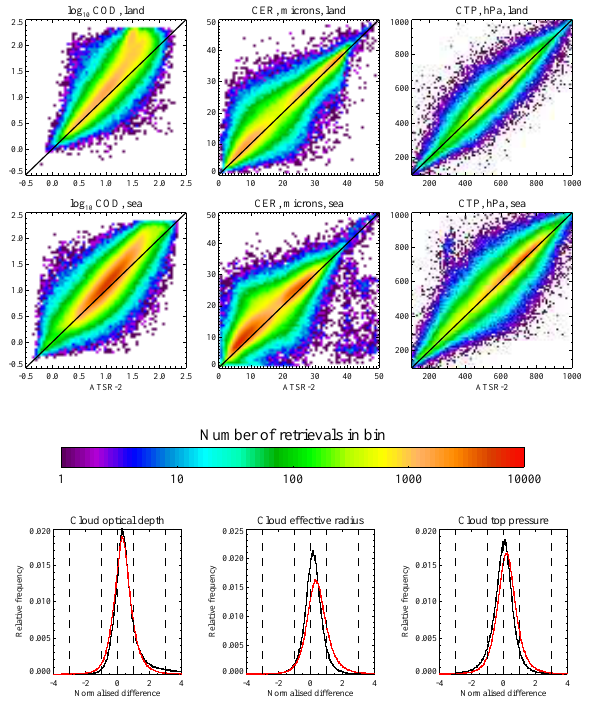
Fig. 3. Joint histograms of quality controlled and colocated ATSR-2 and AATSR cloud properties over land (top row) and sea (second row). From left to right, the columns show the base-10 logarithm of cloud optical depth; the cloud effective radius; and the cloud-top pressure. The colour scale indicates the number of retrievals in each bin. Bottom row: Histograms of the difference (AATSR − ATSR-2) between bin mean retrieved cloud properties, divided by the root sum of the bin variances for that cloud property. This gives a nor- malised (unitless) quantity. The plots are ordered as in the top row. Black lines indicate retrievals over land, and red over sea. Dashed lines indicate 0, ± 1 and ±